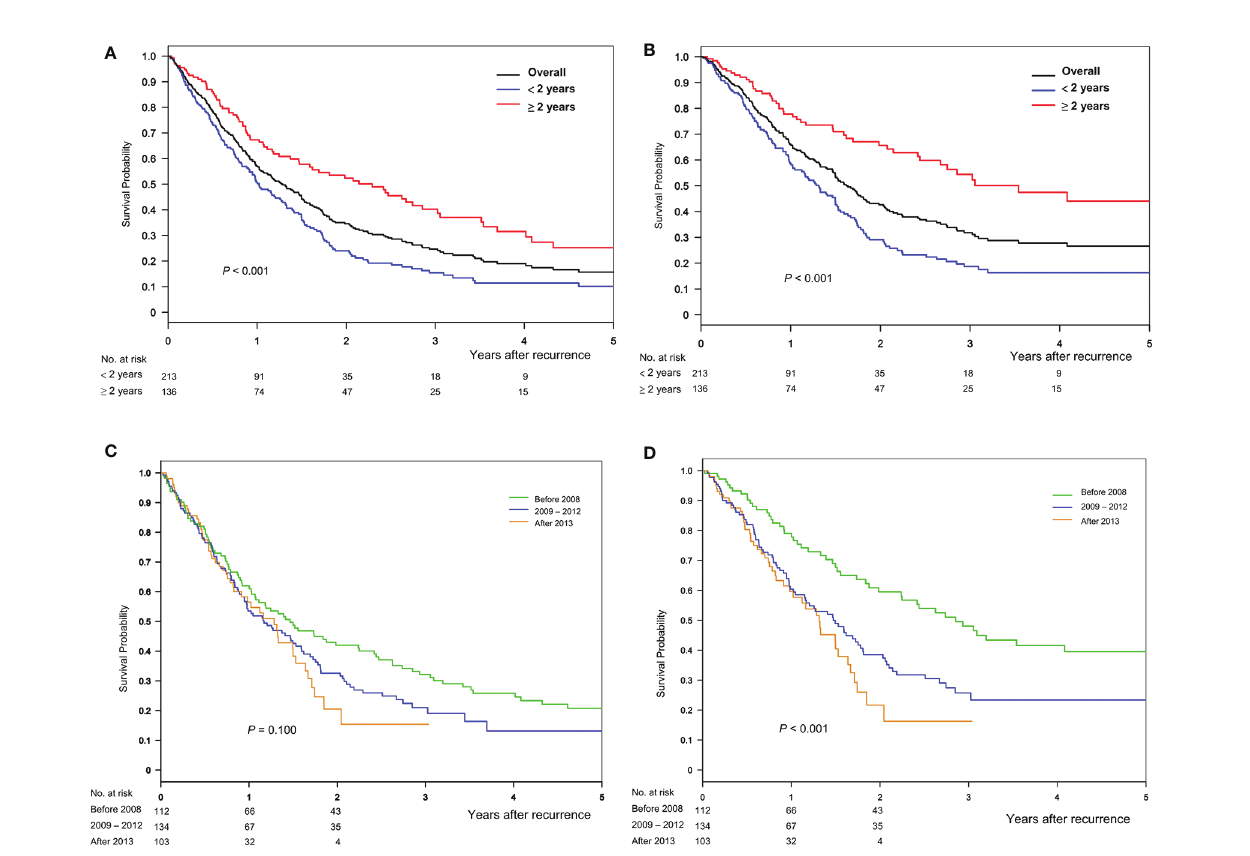
FIGURE 2 | Overall survival and HCC-speci fi c survival after recurrence, strati fi ed based on the timing of (A, B) recurrence and (C, D) transplant era,